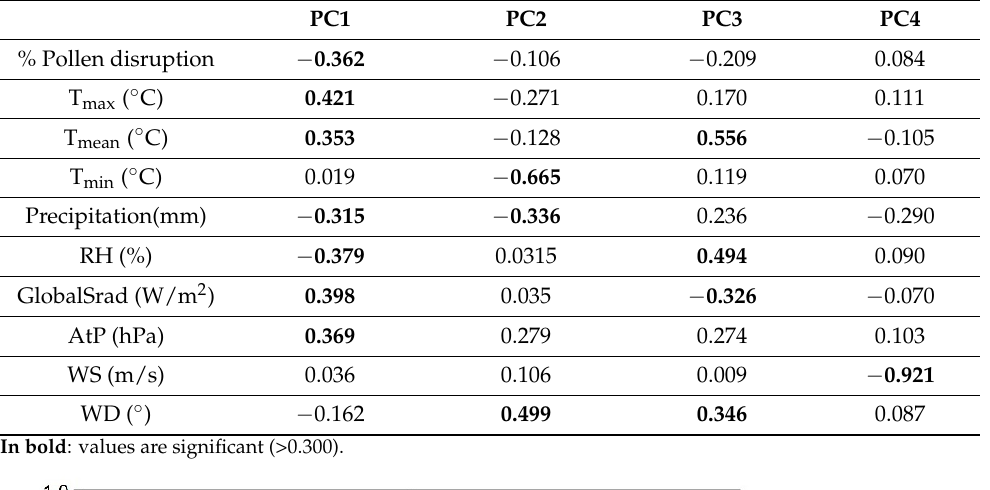
Table 4. Loadings of principal components.